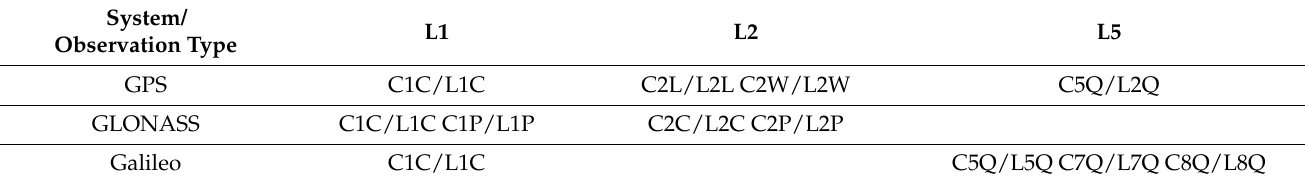
Table 1. Types of the observations used for the analysis for each GNSS system (notation according to RINEX 3.04 format